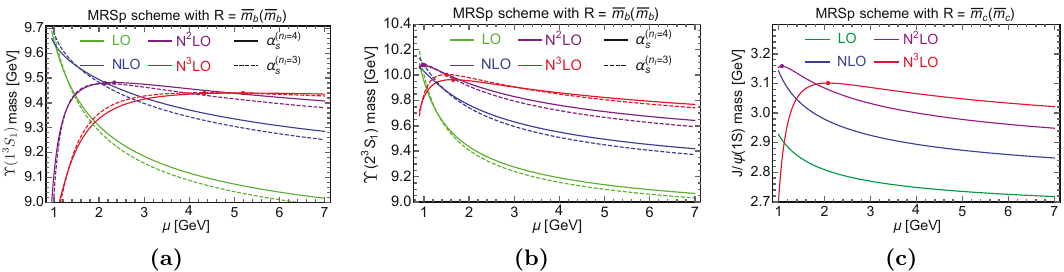
Figure 6. Canonical scales according to the principle of minimal sensitivity. The left (a), center (b) and right (c) panels show the bottomonium (cid:7)(1 3 S 1 ) and (cid:7)(2 3 S 1 ) states, and the charmonium J= (1 S ) state, respectively. In (a) and (b) the solid line shows the (cid:11) ( n ‘ =4) s scheme, whereas dashed lines correspond to the (cid:11) ( n ‘ =3) s scheme. Green, blue, purple and red colors represent LO, NLO, N 2 LO and N 3 LO predictions, respectively. Whenever a maximum is attained, its position is marked with a fat colored